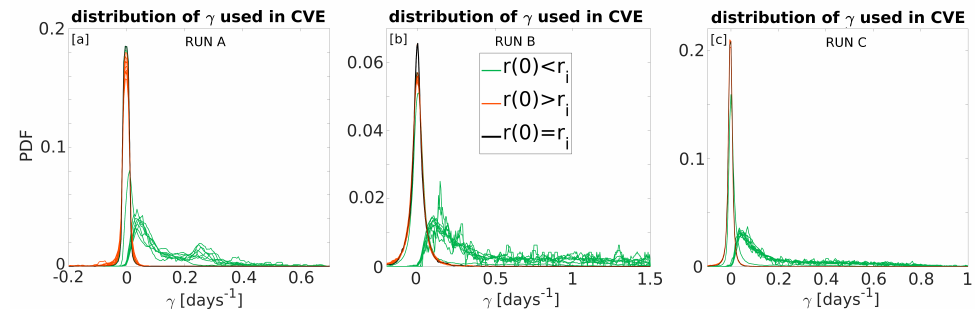
Figure 8. ( a ) Probability density function of the values of γ used in the computation of the CVE ˜ λ at the reference separation threshold r i = 0.35 for model run A. Each line represents a different initial separation. Green and red lines represent initial separations that are smaller and larger than the reference separation r i , respectively. ( b ) Same as ( a ) for model run B. ( c ) Same as ( b ) for model run